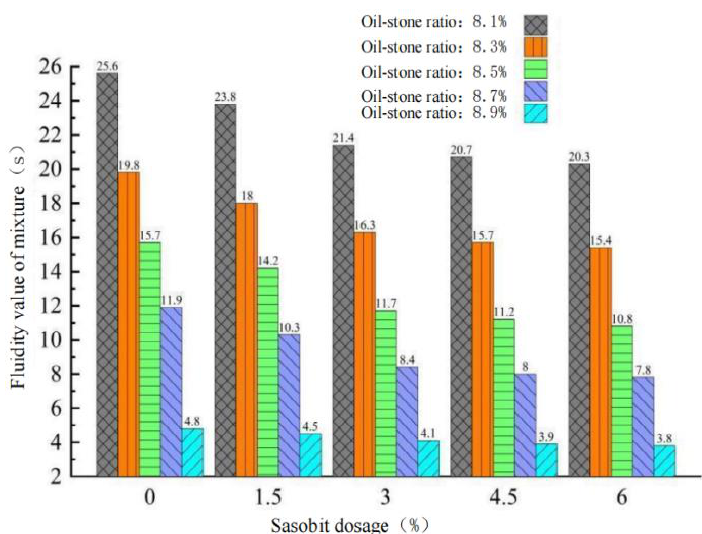
Figure 5. Effect of Sasobit content on fluidity of GA-10 asphalt mixture.